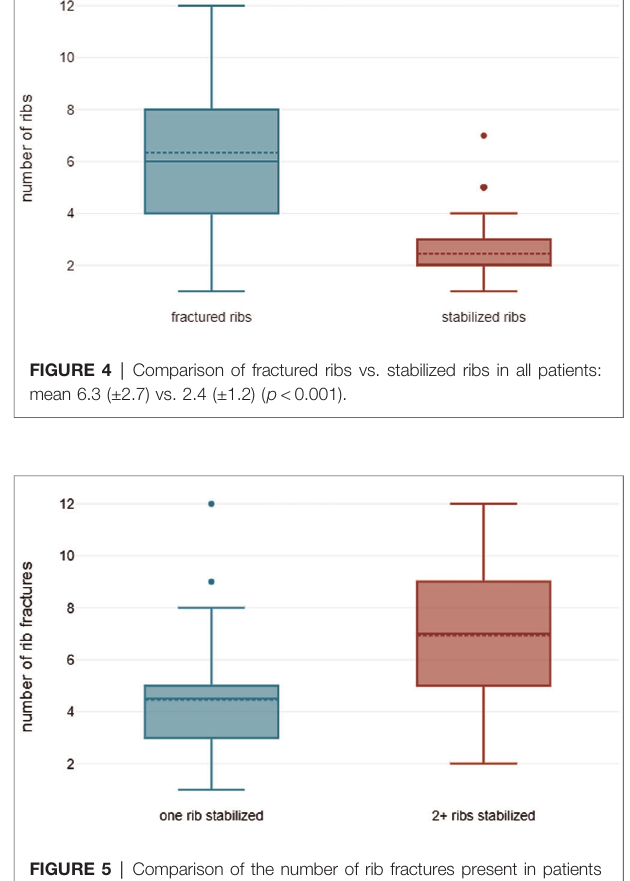
FIGURE 5 | Comparison of the number of rib fractures present in patients undergoing osteosynthesis of a single to two and more ribs: mean 5.7 (±2.8) vs. 7.1 (±2.8) ( p <0.001).